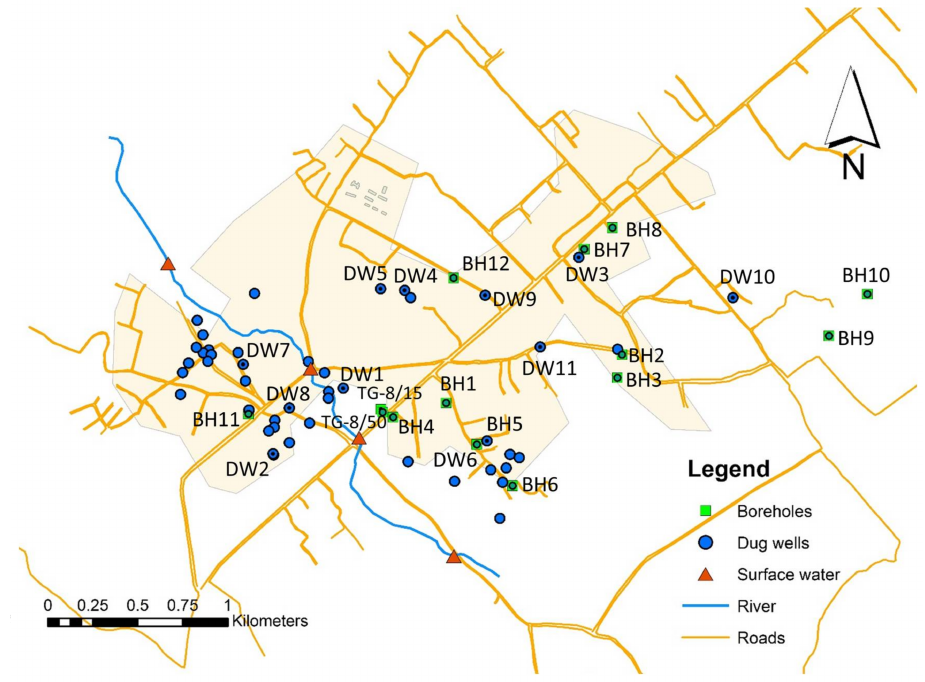
Figure 1. Map of Dodowa with sampling points. The labelled sampling points (black dots) are listed in Table